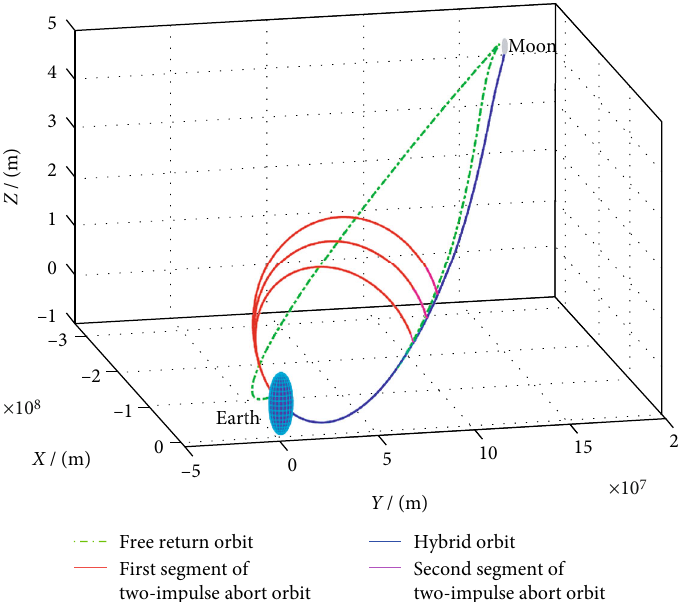
Figure 5: Accurate two-impulse abort orbits in the three cases of two simulation